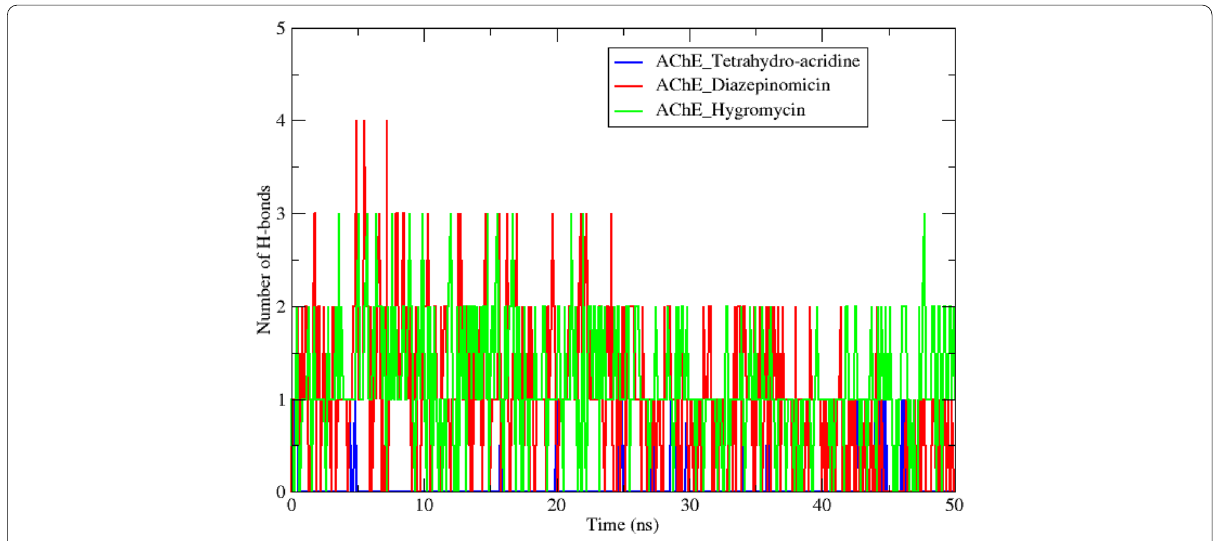
Fig. 8 Number of H-bonds established during 50-ns MD simulations